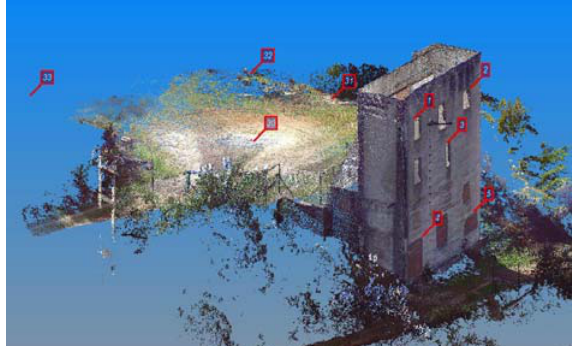
Figure 5: The measurements taken on the building